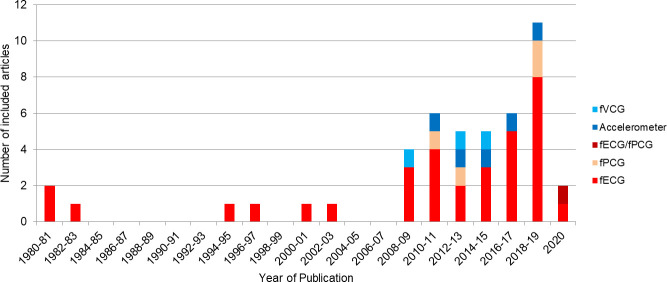
The number of studies included in the review published every two years.Devices have been split into the different technologies used: Fetal electrocardiography (fECG), fetal phonocardiography (fPCG), combined fECG/fPCG, accelerometry and fetal vectorcardiography (fVCG).